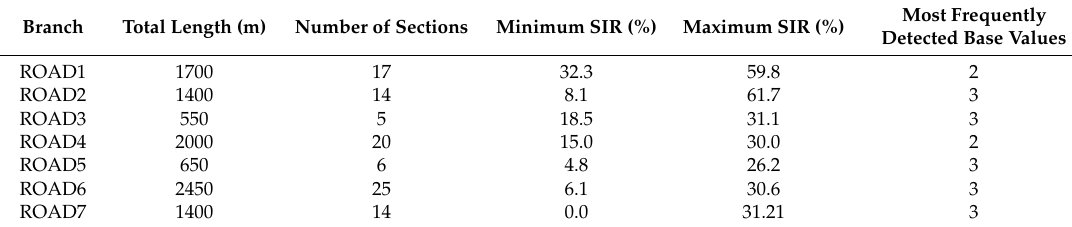
Table 8. Characteristics of the selected roads.